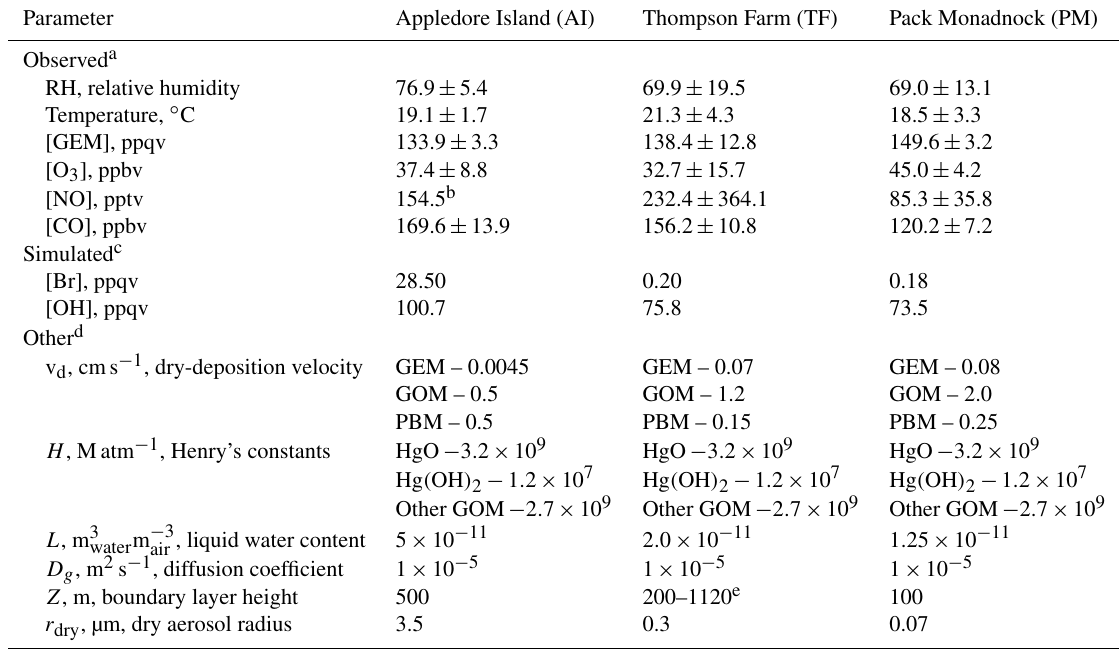
Table 2. Box model input and simulated variables.